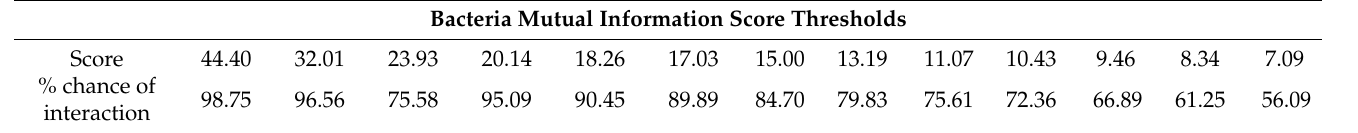
Table 2. The different probability thresholds for mutual information scores for bacteria. Bacteria Mutual Information Score